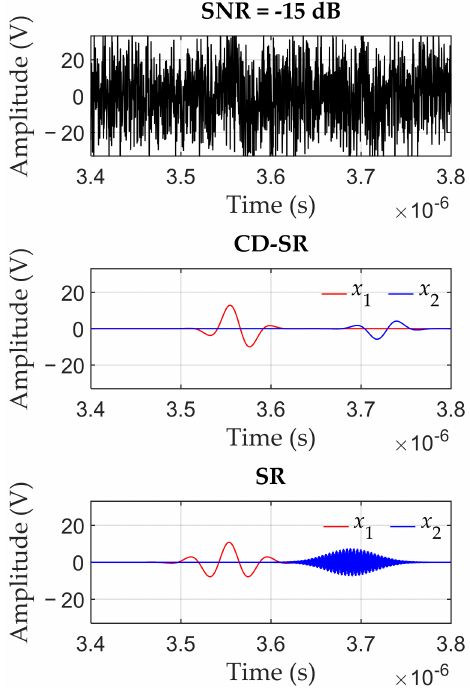
Figure 10. Comparison of reconstructed echoes (SNR = − 15 dB).